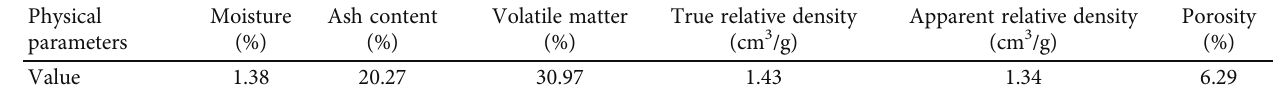
Table 1: Physical parameters of coal sample.